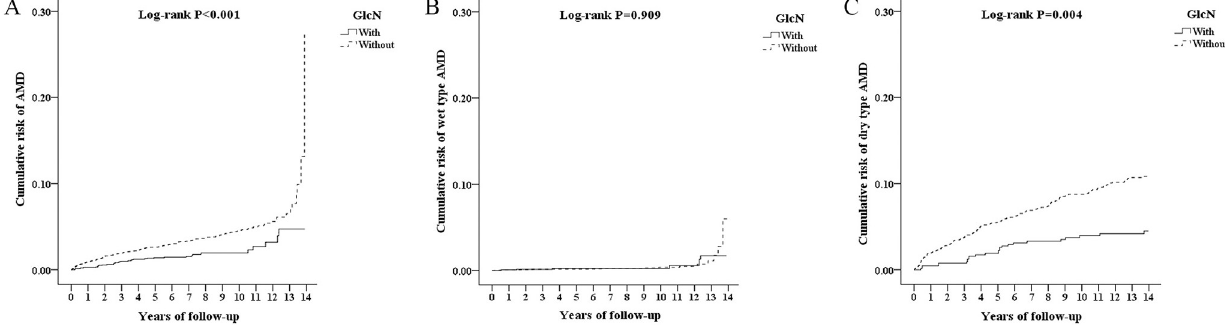
Fig 2. Cumulative risk of AMD in patients stratified by GlcN use, calculated by the Kaplan-Meier method with log-rank test. (A) all AMD; (B) Wet type AMD; (C) Dry type AMD. AMD, Age-related macular degeneration; GlcN,